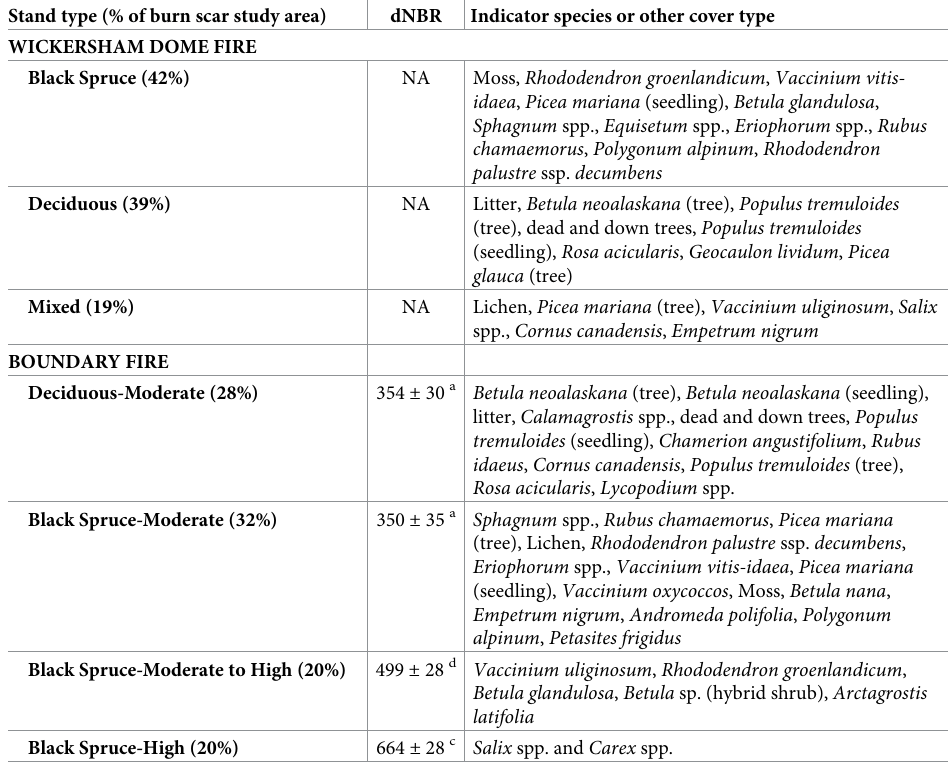
Table 1. Wickersham dome fire and the boundary fire stand